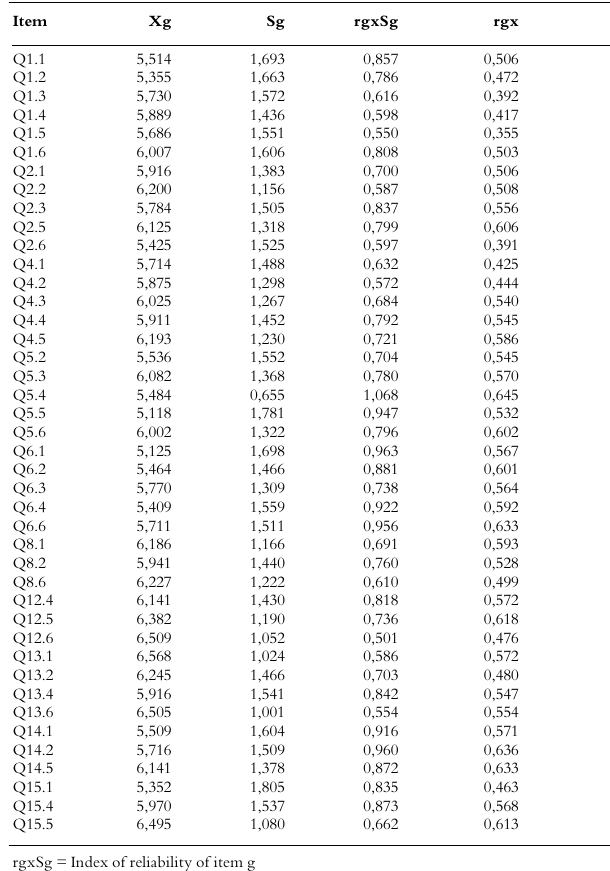
TABLE 7 ITEM STATISTICSIN RESPECTOF SCALE I